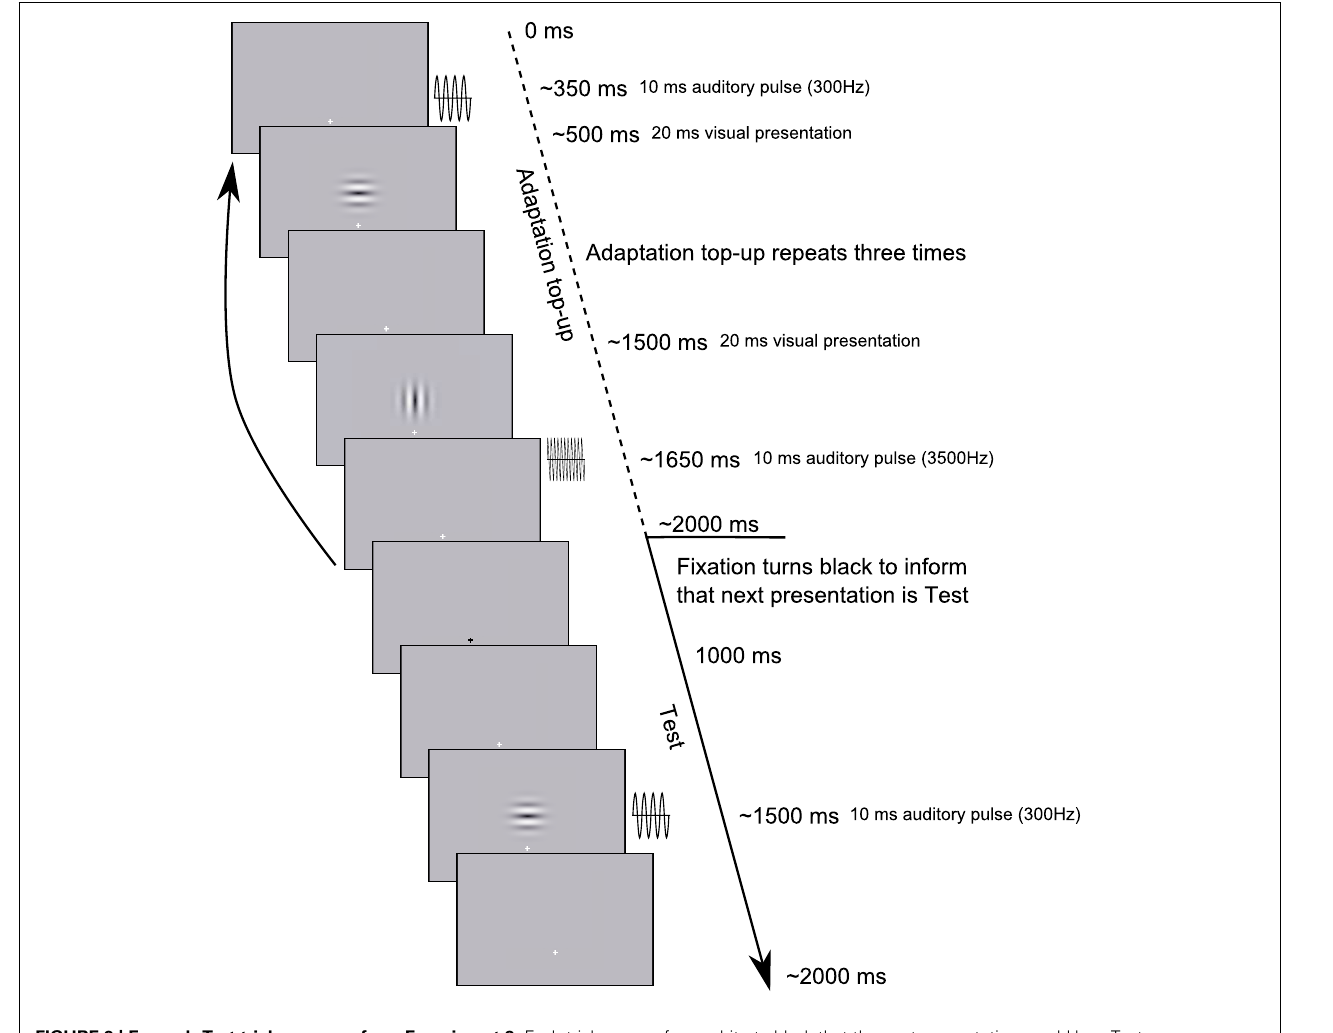
FIGURE 3 | ExampleTest trial sequence from Experiment 2. Each trial began with an Adaptation top-up period during which three repeats of each of the adapting relationships from the previously presented Adaptation phase were repeated. Following the top-up period, participants were informed by a transient change in the fixation cross